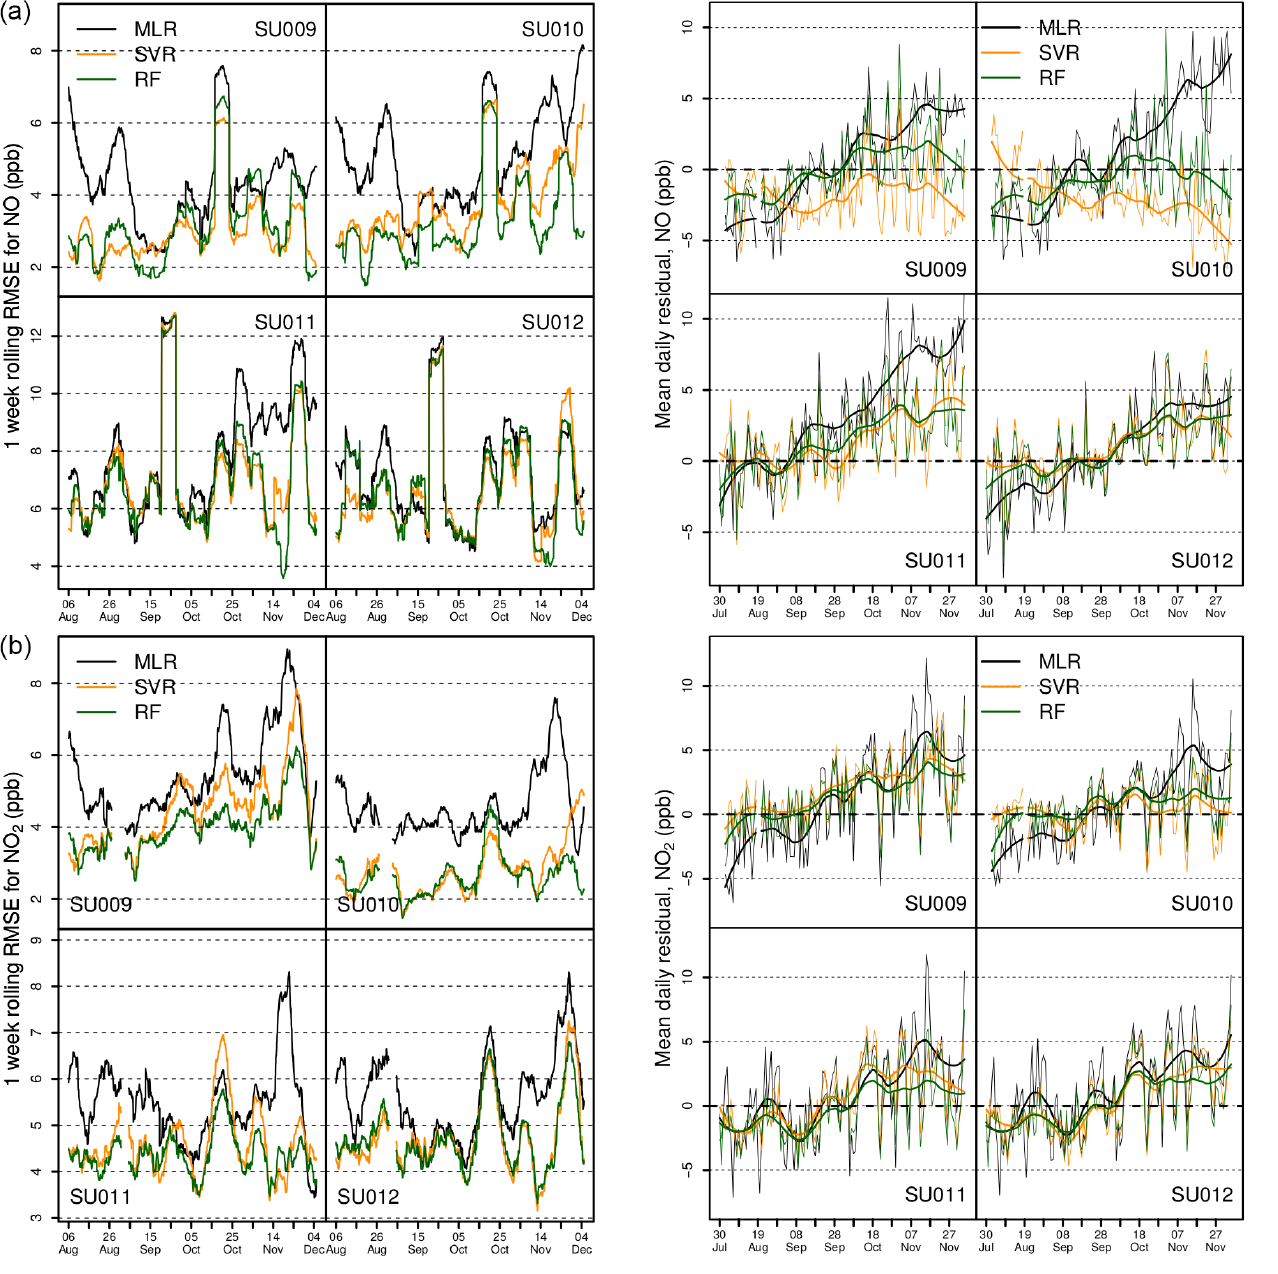
Figure 7. Timeseries of 1 week rolling RMSE for 10min data of NO (a) and NO 2 (b) at the deployment sites.